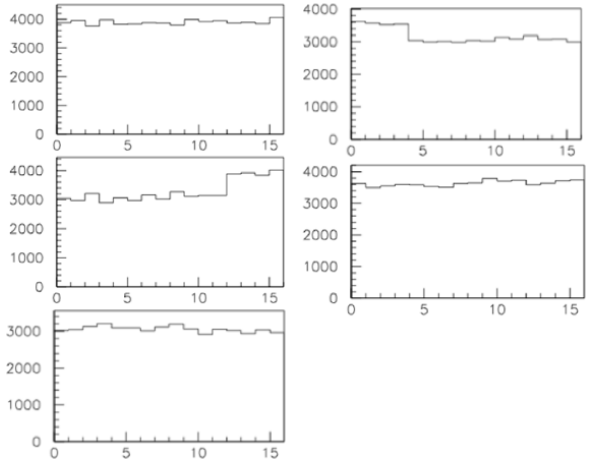
Figure 6. Occupancy plots for one module of the QCALT calorimeter. All the module channels are on and equalized as showed.